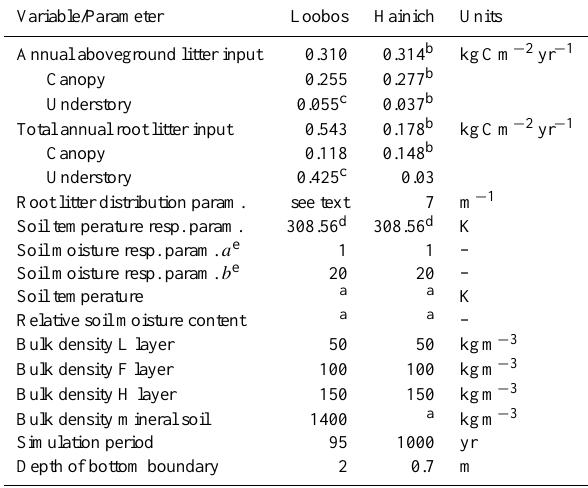
Table 1. Model driving data and not-estimated